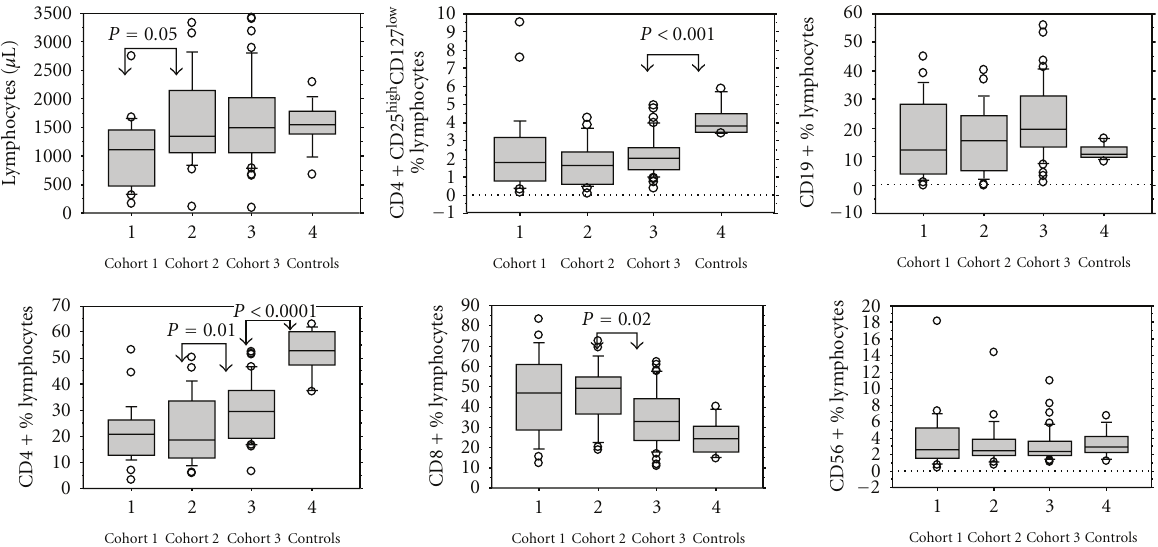
Figure 3: Lymphocyte subpopulations and Treg within di ff erent time periods from HSCT. Box plots graphs of lymphocyte subpopulation frequencies in the three patient cohorts and in normal controls. The grafts show the dispersion around the median. The line across each box represents the median for patients in cohort 1 ( n = 26, median time from HSCT 244 days), in cohort 2 ( n = 22, median time from HSCT 510 days), in cohort 3 ( n = 36, median time from HSCT 720 days), and for normal controls ( n = 20). The bottom edge is the first quartile and the top edge is the third quartile, the error bars represent the dispersion within the 95% confidence interval, the dots represent extreme values. Di ff erences between the groups were explored using the Mann-Whitney U -test. Significant di ff erences between the groups are shown above ( P < 0 . 05). All other di ff erences between the median values were not significant ( P > 0 . 05). CD: cluster of di ff